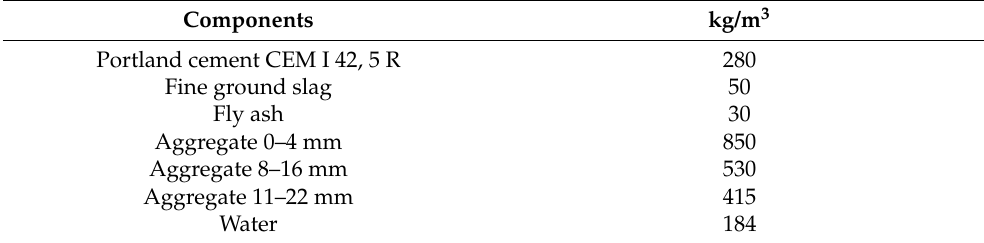
Table 1. Concrete mixture composition.